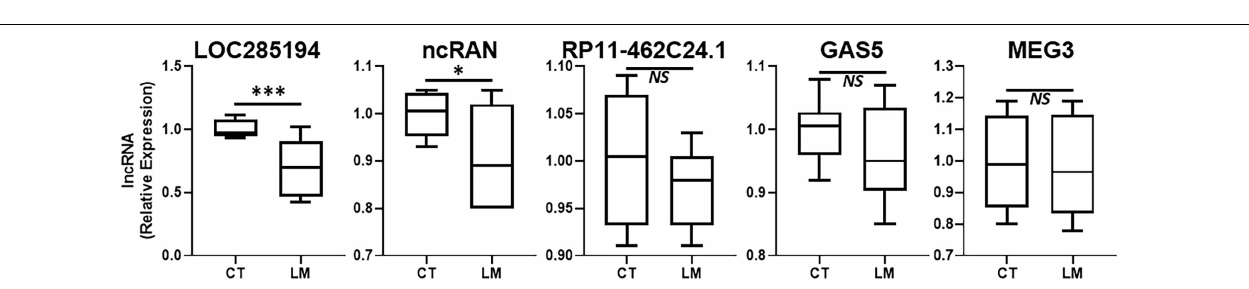
FIGURE 2 | Downregulated lncRNAs in colorectal cancer liver metastases. Expression levels of several lncRNAs were tested in liver metastases (LM) of primary colorectal cancers, by qRT-PCR, and compared to their expression levels in adjacent non-cancer liver tissues (CT: control). N = 8 * p < 0.05, *** p < 0.001, and NS ,